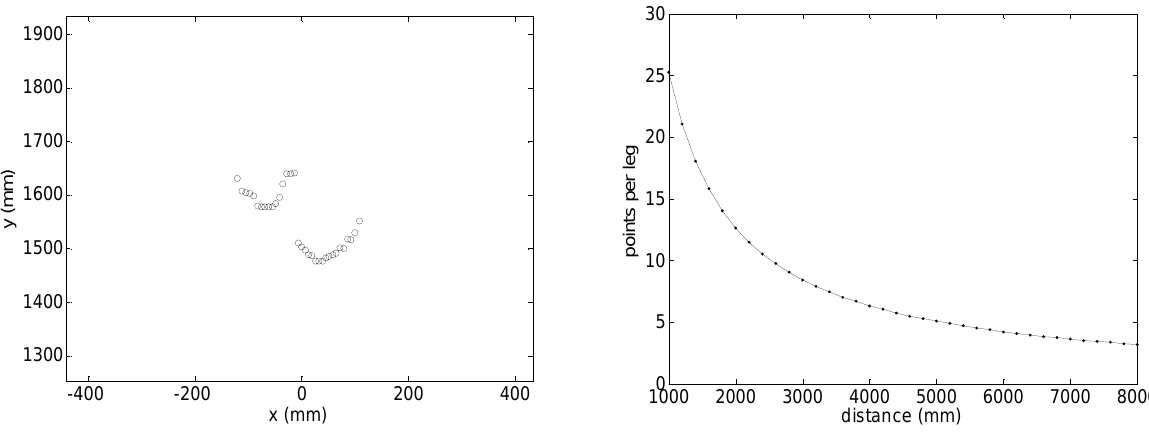
Figure 5. Left: typical scan data showing two legs of a walking volunteer. Right: estimation of the number of measurement points available in one leg relative to the